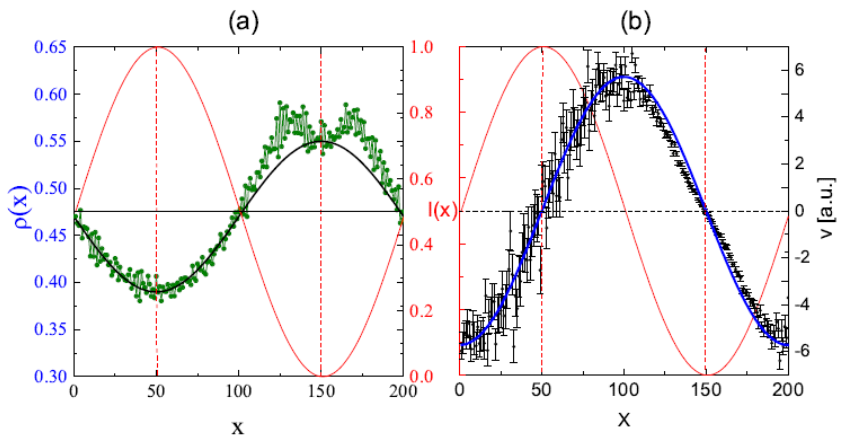
Figure 10. ( a ) Plot of monomer density profile ρ ( x ) at the end of the simulation and plot of scaled sine function (black solid curve). ( b ) Plot of macroscopic velocity v x of the CM of the chains, fitted with scaled gradient of the illumination ∇ I (blue solid curve). Red line—the light illumination pattern I ( x )